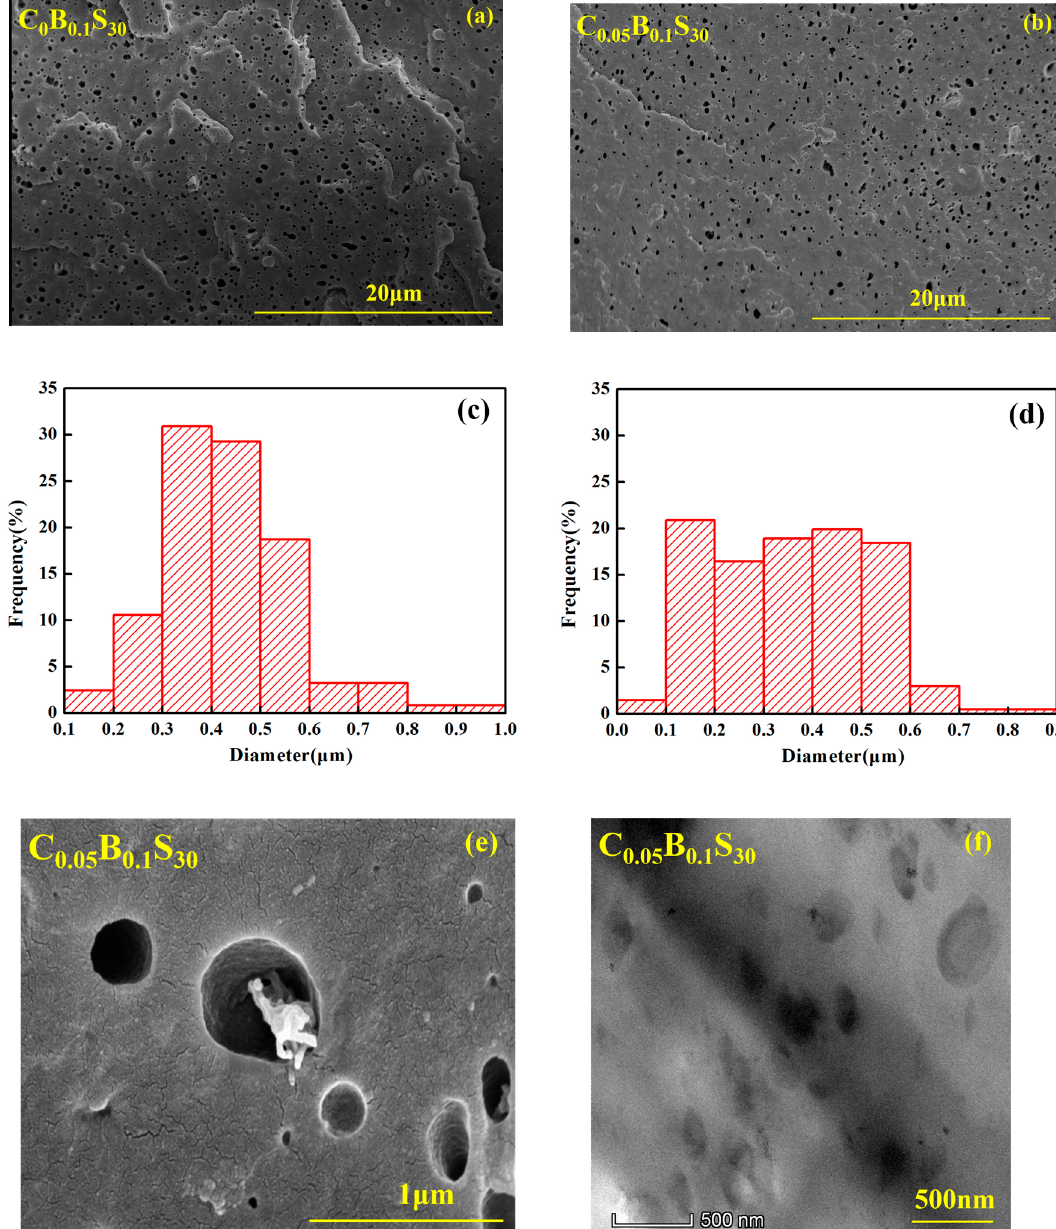
Figure 8. SEM micrographs of of PPR blends with 30 wt % SBS after etched bytetrahydrofuran ( a , b ); SBS size distribution of C 0 B 0.1 S 30 ( c ) and C 0.05 B 0.1 S 30 ( d ); enlarged SEM ( e ) and TEM ( f ) image of C 0.05 B 0.1 S 30 .